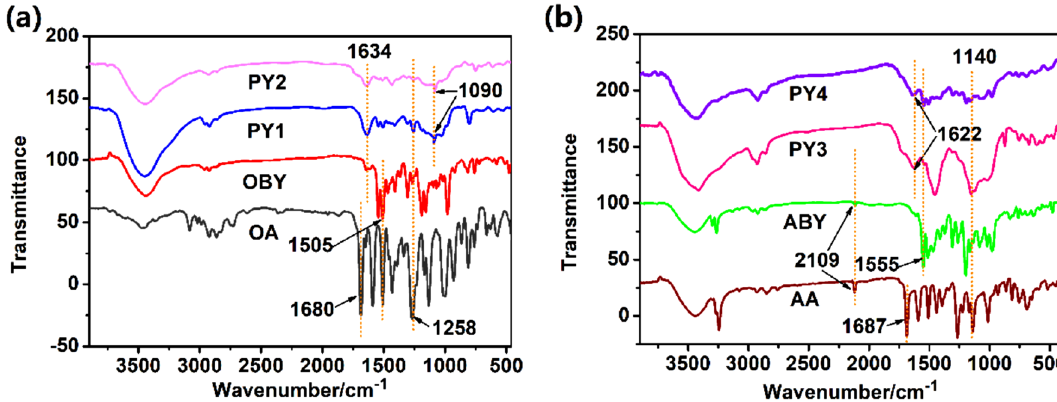
Fig. 1 FTIR spectra of a OA, O-BODIPY, PY1 and PY2, and b AA, A-BODIPY, PY3 and